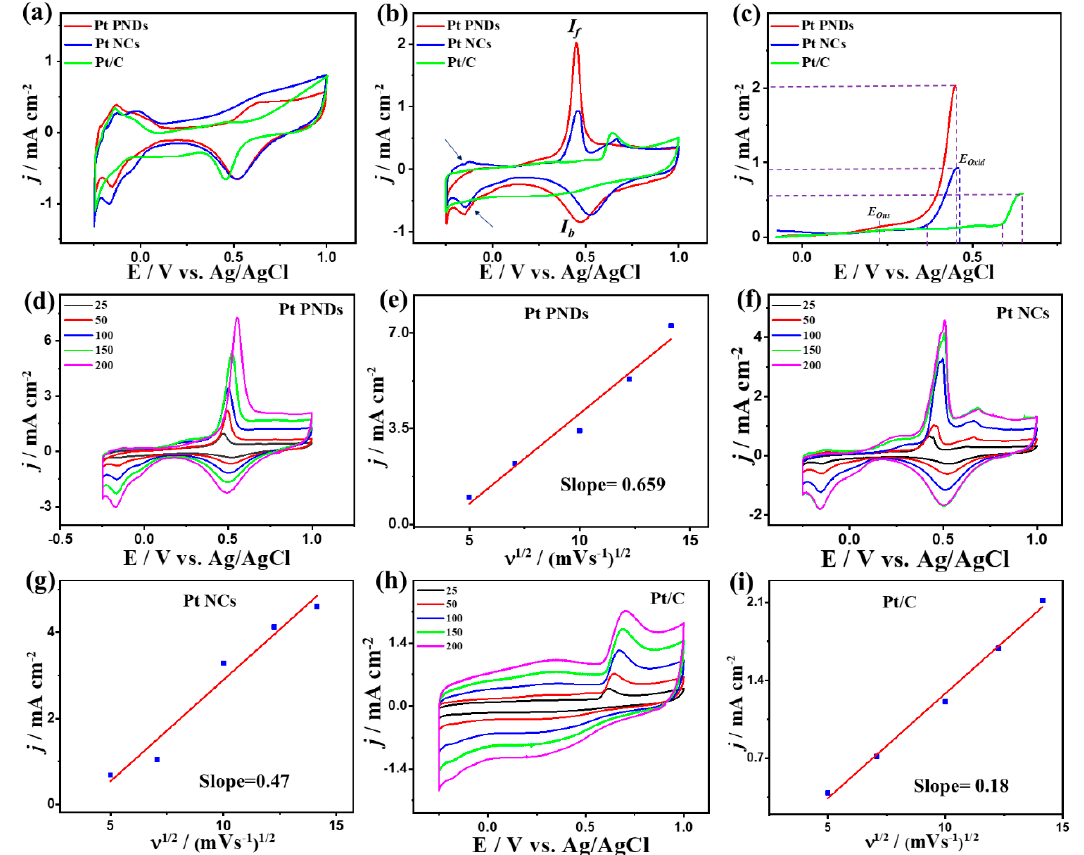
Figure 3. ( a ) CVs in N 2 -staruraed 0.1 M HClO 4 , ( b ) CO-saturated 0.1 M HClO 4 at 50 mV/s, and ( c ) LSV at 50 mV/s of Pt NDs, Pt NCs, and Pt/C. CV curves at different scan rates and their related plots of I f vs. v 1/2 on ( d , e ) Pt NDs, ( f , g ) Pt NCs, and ( h , i ) Pt/C in CO-saturated 0.1 M HClO 4 .